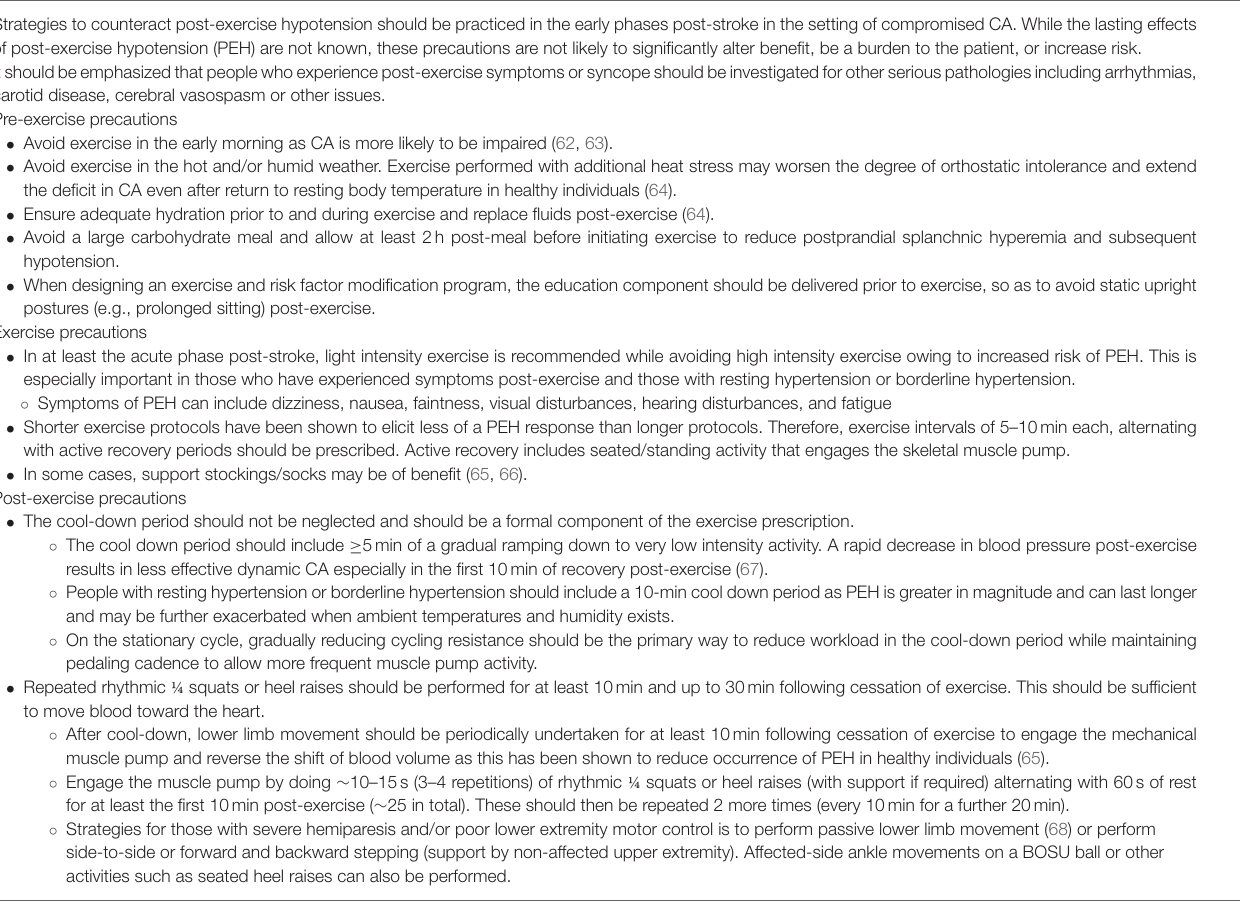
TABLE 6 | Guideline 5.0: Precautions to prevent post-exercise or mobilization